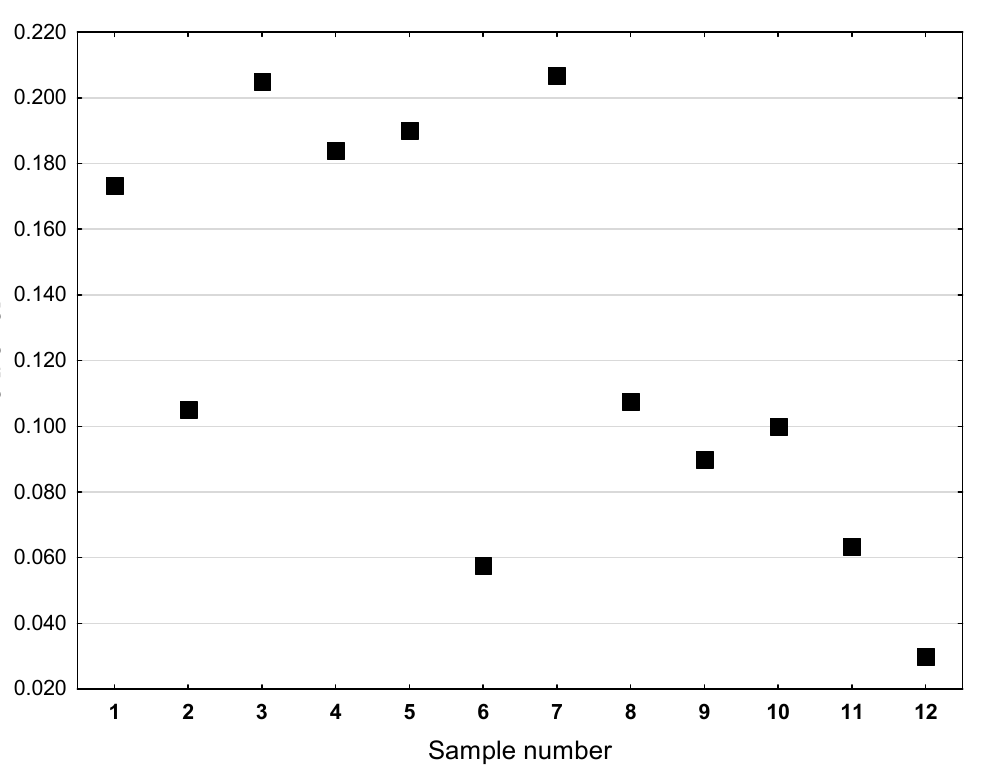
Figure 4. Hg concentrations in dietary supplements made with cod liver oil (µg/kg).